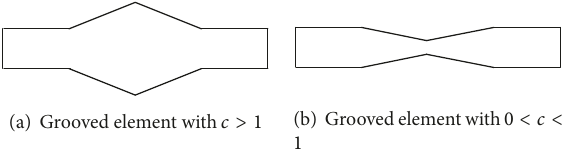
Figure 7: Grooved beam system schematics.